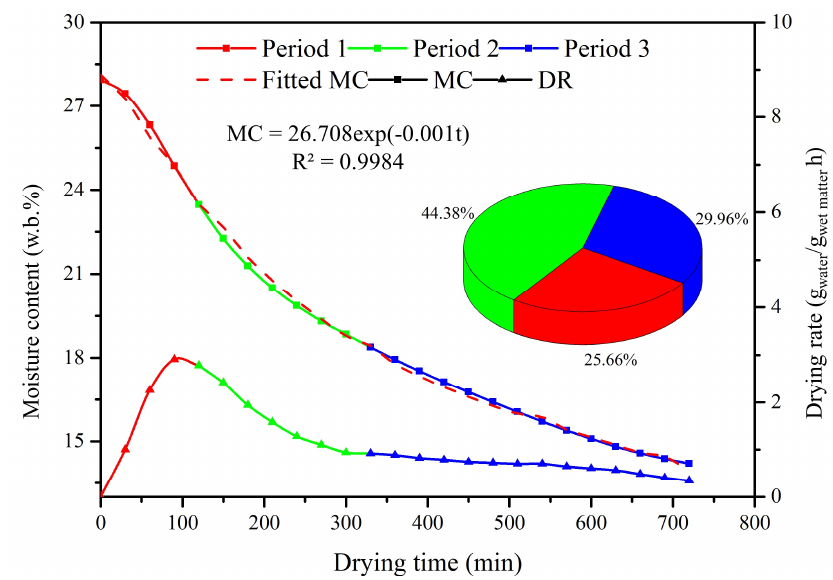
Figure 6. Kinetics curves of the corn drying process.